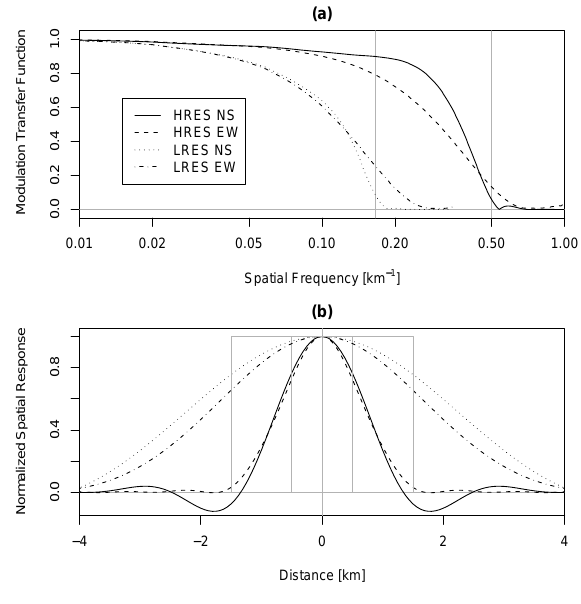
Fig. 2. (a) Modulation transfer function (MTF) of the 3 × 3km 2 low-resolution(LRES) 0.6 and 0.8µm channels and the 1 × 1km 2 high-resolution visible channel (HRES) for Meteosat-9 in North- South (NS) and East-West (EW) directions (EUMETSAT, 2006a). The Nyquist frequencies corresponding to the sampling resolution km − 1 (LRES) and 1 are shown in grey, with values of 1 km − 1 6 2 (HRES). (b) Point spread function of the SEVIRI detectors recon- structed from the MTFs (see text for details), as a function of dis- tance from the pixel center. In grey, a perfect step response at LRES and HRES sampling resolution is also